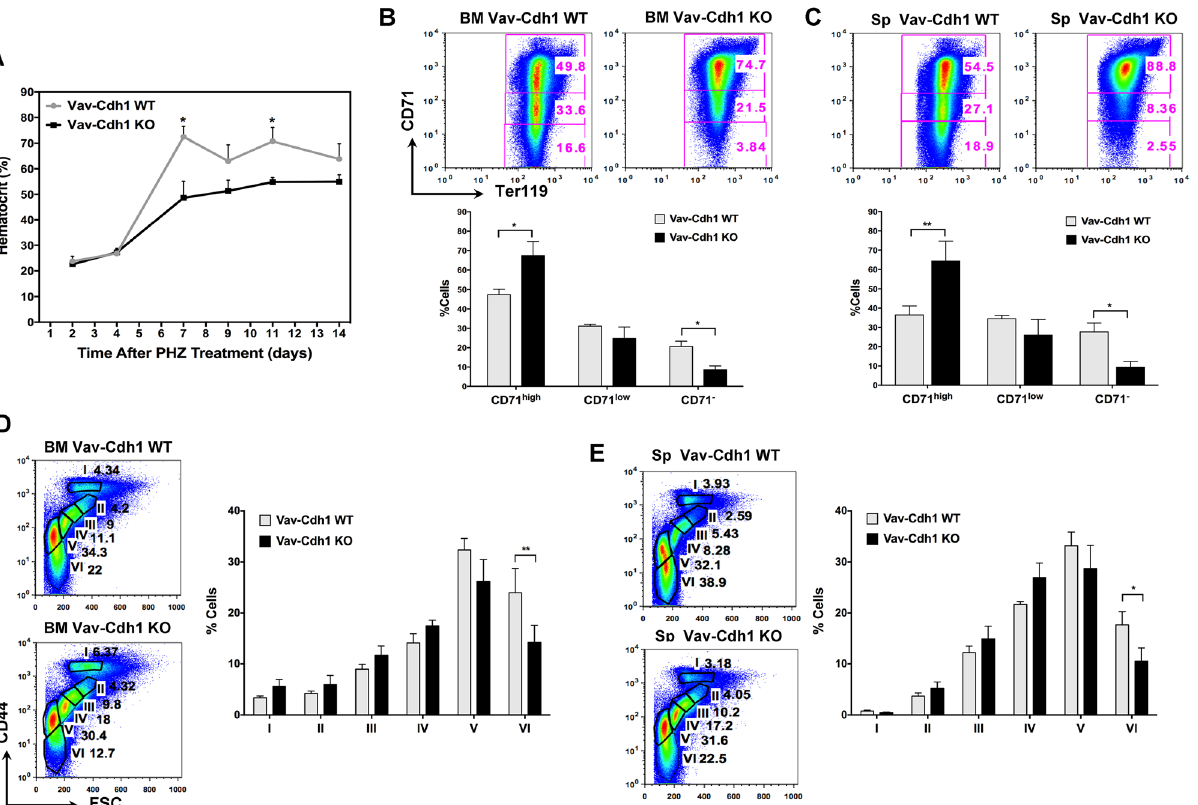
Figure 3. Slow recovery from hemolytic anemia and inefficient stress erythropoiesis in hematopoietic Cdh1- depleted mice. ( A ) Hematocrit values in control (Vav-Cdh1 WT, grey) and Cdh1-depleted (Vav-Cdh1 KO, black) animals at day 2, 4, 7, 9, 11 and 14 following PHZ injection. Each point represents the mean ± s.e.m of values obtained from 5 different animals of the corresponding genotype. ( B , C ) Seven days after PHZ treatment mice were sacrificed and terminal erythroid maturation was assessed in bone marrow ( B ) and spleen ( C ) based on CD71 expression in Ter119 + gated cells. The relative abundance of populations showing high, low, or no CD71 expression, representing increasingly higher maturation stages, was quantified (bottom graphs). Representative flow cytometry plots are included (top panels). ( D , E ) CD44-FSC (Forward Scatter) based staging of erythroid populations in the bone marrow ( D ) and spleen ( E ) of PHZ-treated mice of the indicated genotype after seven days of recovery. Population I corresponds to proerythroblasts, II, III and IV to